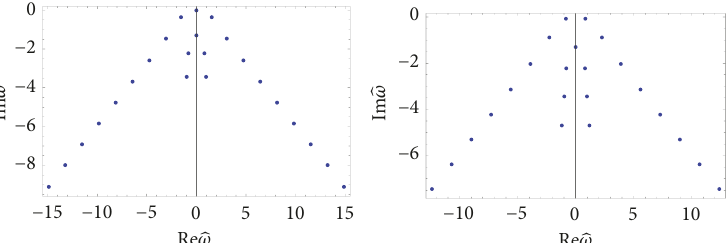
Figure 6: QNMs (blue spots) of the gauge mode for 𝛾 1 = −1 and ̂𝛼 = 0 . The left panels are the QNMs of the gauge mode and the right ones are that of the dual gauge